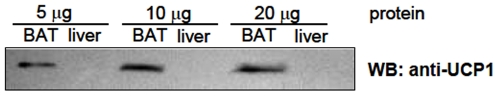
UCP 1 expression in BAT and liver mitochondria.Five to twenty micrograms of mitochondria derived from BAT and liver were used to load the gel. The immunodetection was obtained with UCP 1-specific polyclonal antibody.